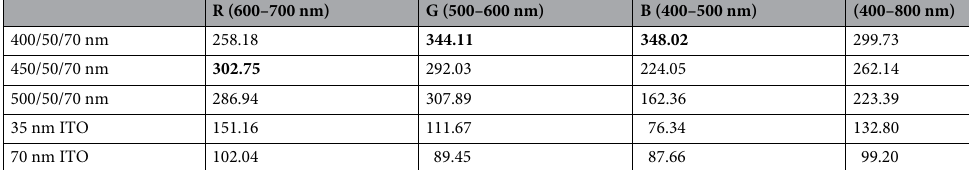
Table 4. Calculated FoMs from the measured transmittance within three different wavelength ranges and sheet resistance. Significant values are in [bold].